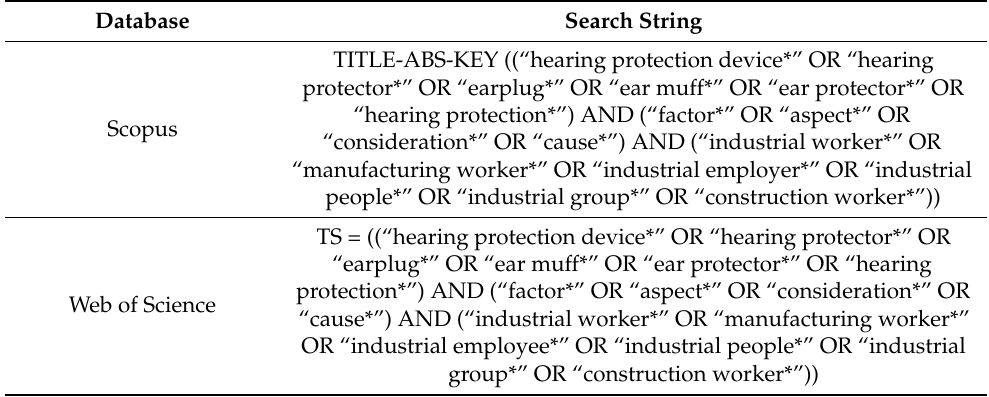
Table 1. The search string. Database Search